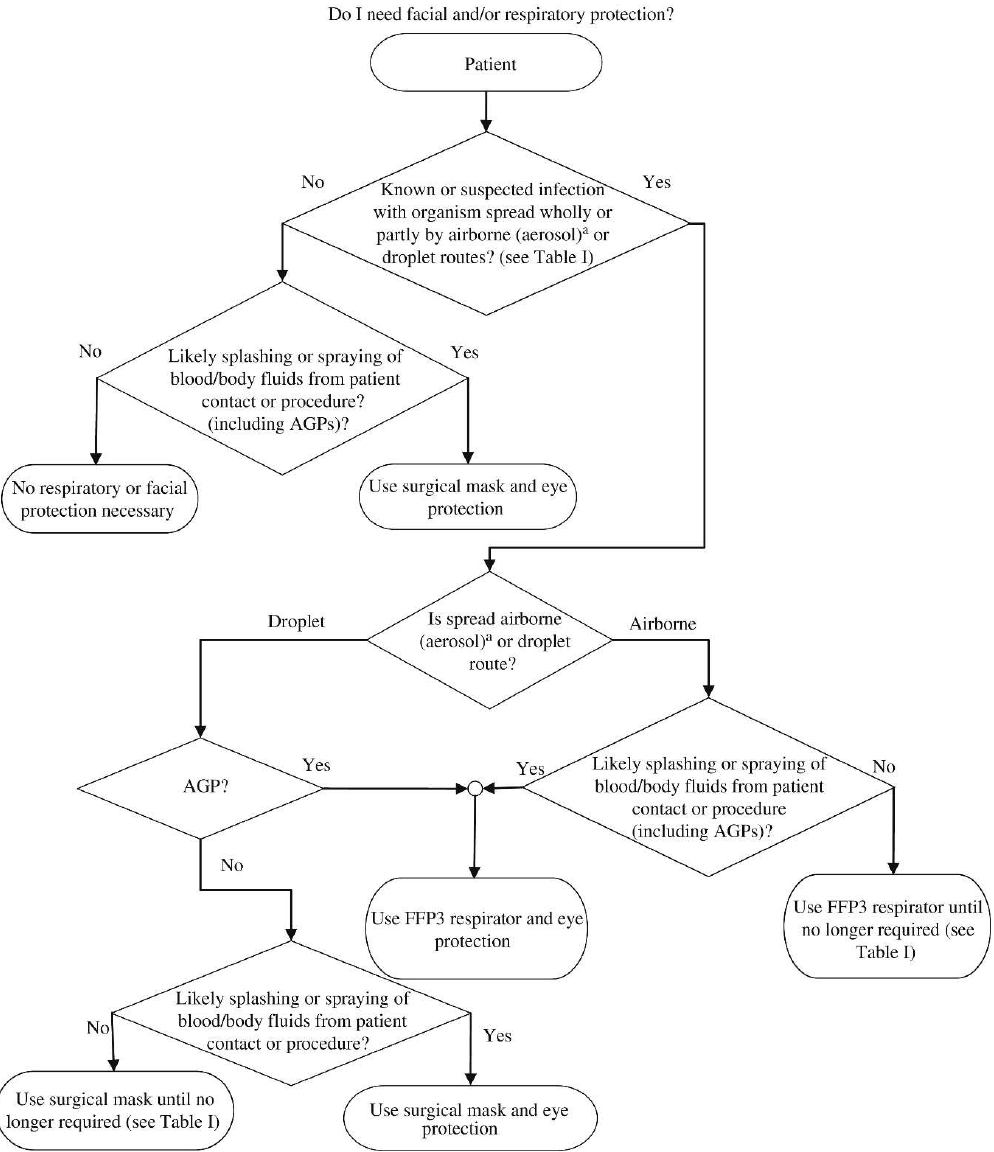
Figure 4. Flow chart illustrating the process to be followed to select the required respiratory